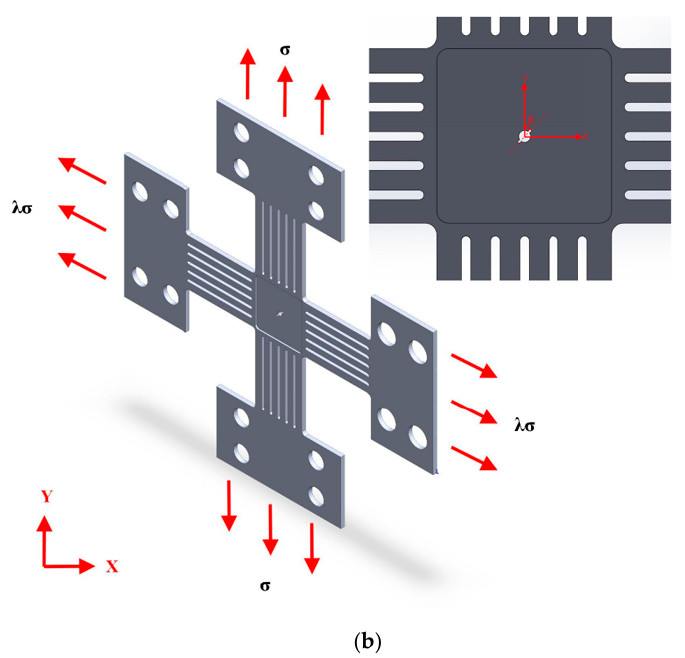
Figure 2. The cruciform specimen. ( a ) Dimension of cruciform specimen and ( b ) three-dimensional specimen ( λ = 0, 0.5, and 1). σ is the load in the Y direction, λσ is the load in the X direction . The overall dimensions of the specimen are 100 × 100 (mm), with a thickness of 1.2